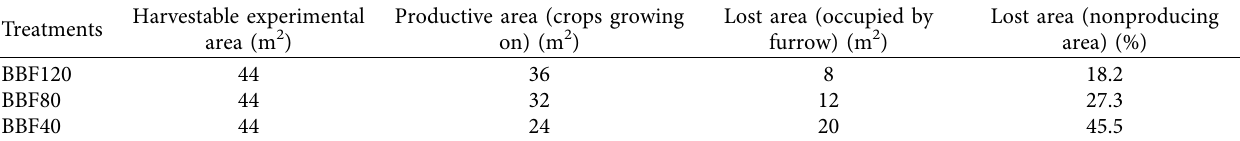
Table 5: Land proportion used for growing crops and making furrows for different soil drainage methods. Harvestable experimental Treatments